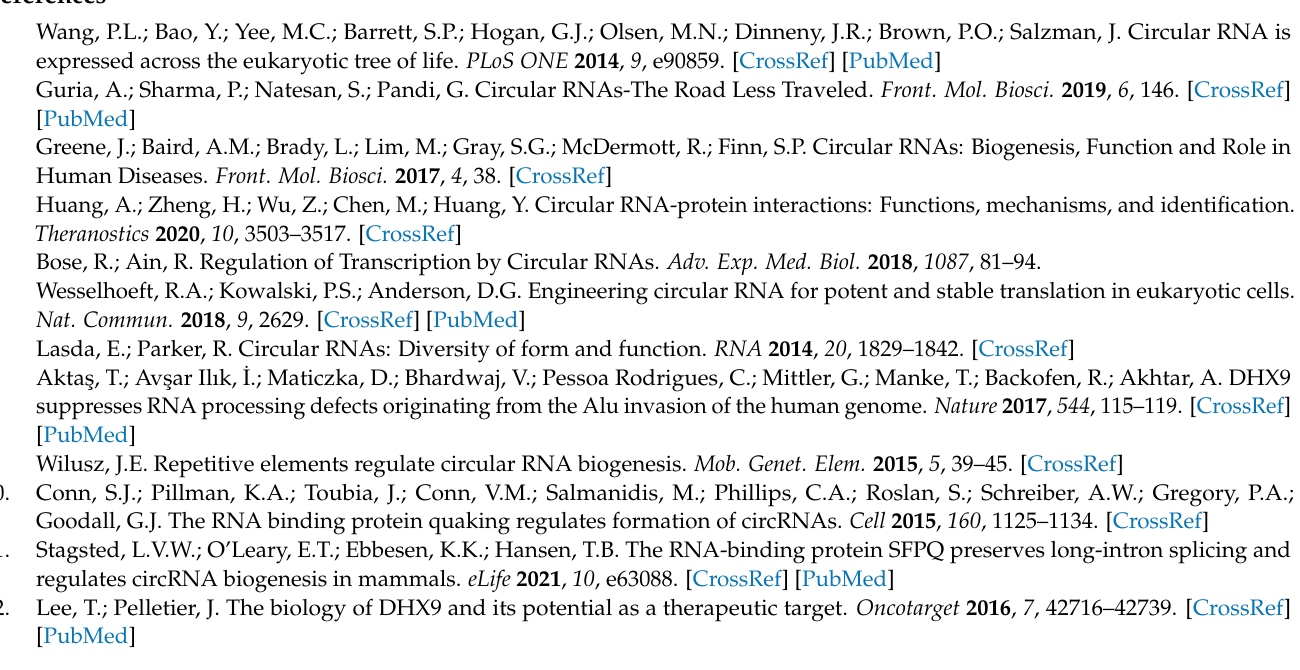
Abbreviations used in publication; Supplementary Table S2: List of overexpression vectors; Supple- mentary Table S3: List of primers; Supplementary Table S4: List of stable cell lines